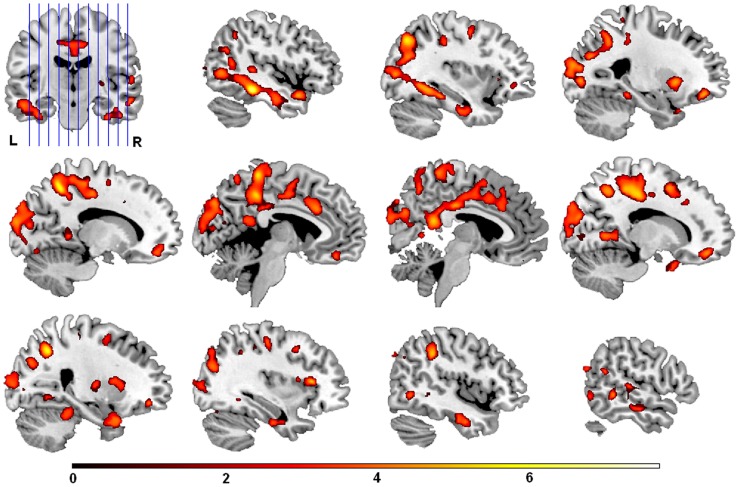
CSF T-Tau/Aβ42 and mean diffusivity.Higher T-Tau/Aβ42 at baseline was associated with increased mean diffusivity in follow-up scanning in several brain regions, encompassing both gray and white matter. As shown above, this relationship was especially prominent in temporal lobe white matter adjacent to hippocampus, but also encompassing gray and white matter in frontal and parietal lobes, portions of occipital white matter, and small clusters in cerebellum. Results are FDR corrected for multiple comparisons (p<.05) and displayed here with a cluster size threshold of 20 or more voxels. Sections are shown in sagittal view beginning from the left side of the brain to right. Variations in the color map reflect the size of the T-statistic (indexed by the color bar at bottom).